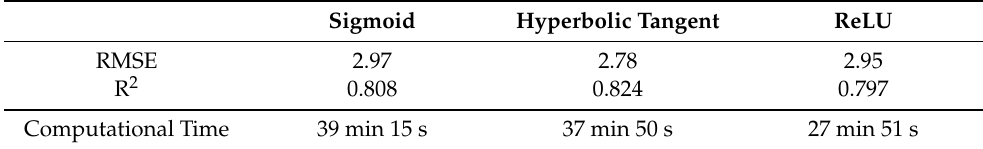
Table 2. Hyperparameter tuning—comparison of the results for the prediction of the SO 2 flow rate with three different transfer functions: sigmoid, hyperbolic tangent, and